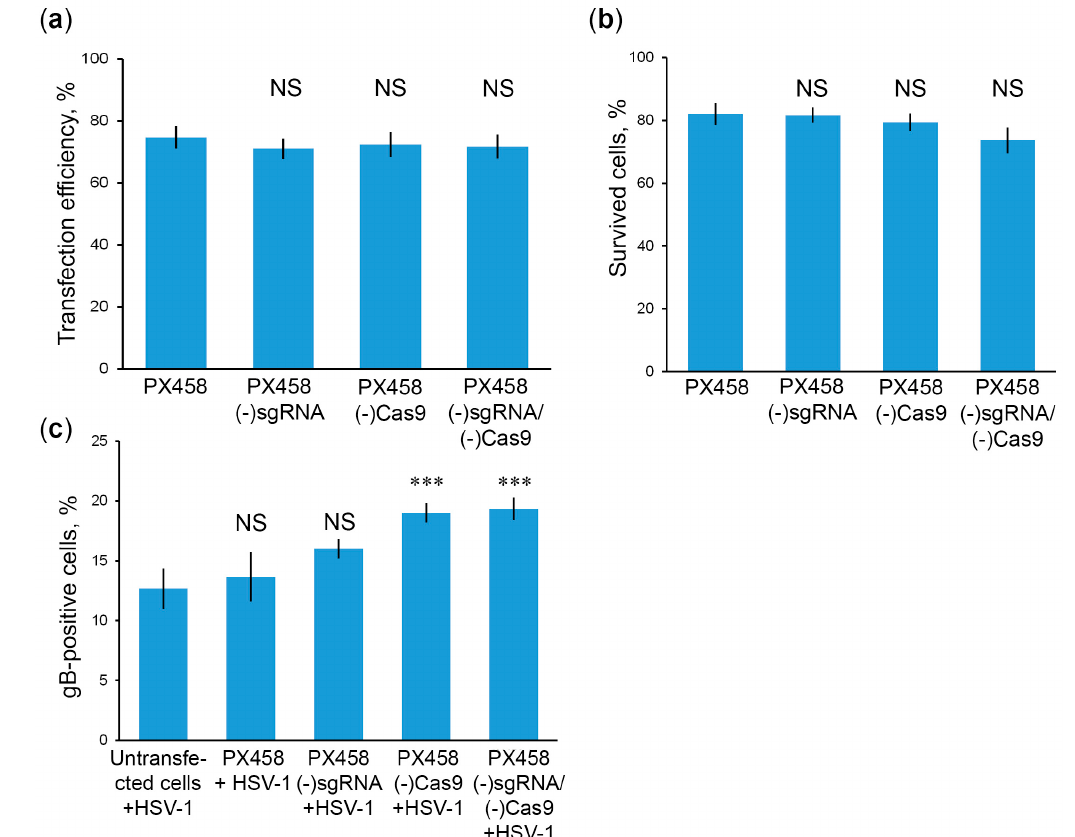
Figure 4. CRISPR/Cas9 components contribute to attenuation of HSV-1 infection. ( a ) Efficiency of transfection of plasmids with disrupted CRISPR components; ( b ) Proportion of surviving cells after transfection with mutant CRISPR plasmids; ( c ) Proportion of gB-positive cells in cultures transfected with CRISPR plasmids at 2 dpi. Data are mean ± SD ( n = 3). Statistical significance: NS–nonsignificant; *** p < 0.001, according to Student’s t test.